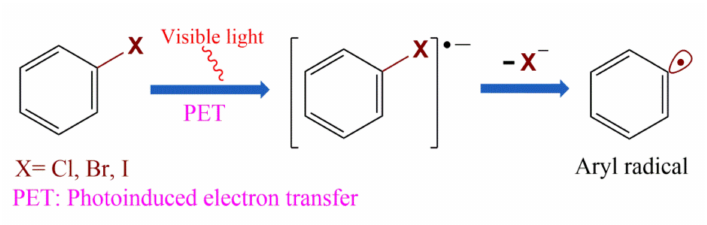
Figure 1. Generation and transformations of aryl